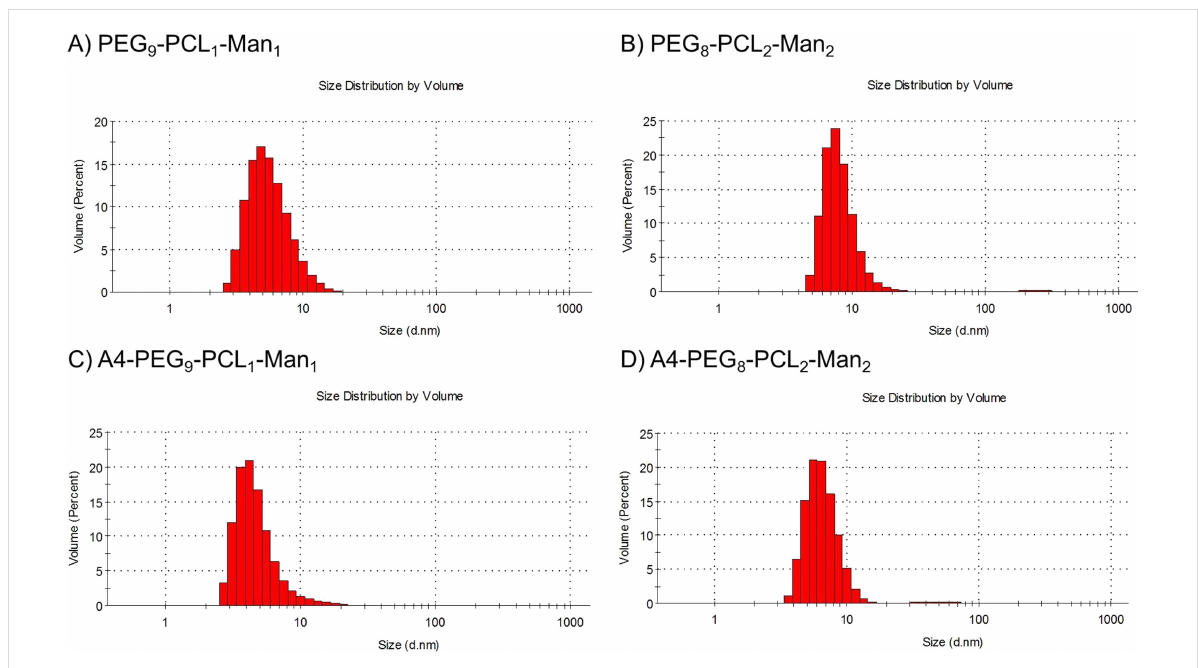
Figure 5: DLS size distribution (vol %) of the glycopolymers PEG 9 -PCL 1 -Man 1 (A), PEG 8 -PCL 2 -Man 2 (B), A4-PEG 9 -PCL 1 -Man 1 (C), A4-PEG 8 - PCL 2 -Man 2 (D), tested in water (1 mg/mL) at 25 °C.